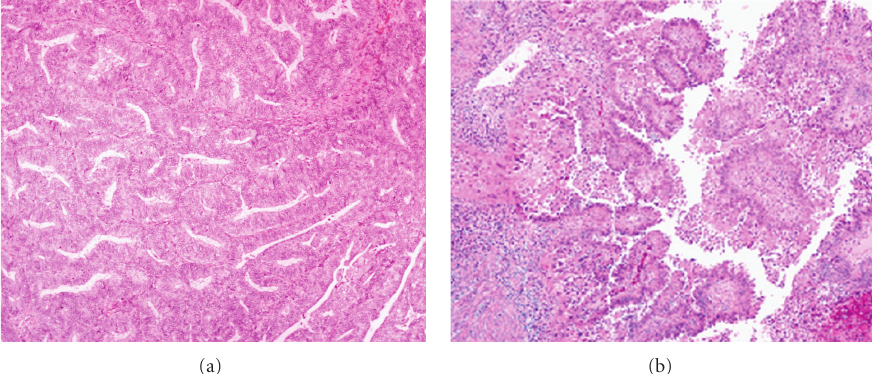
Figure 1: The prototypes for the dualistic model of endometrial carcinoma. Type I endometrioid endometrial carcinoma shows glands lined by stratified neoplastic columnar cells (a), × 100; and type II serous carcinoma showing papillary structures and high nuclear grade (b), ×